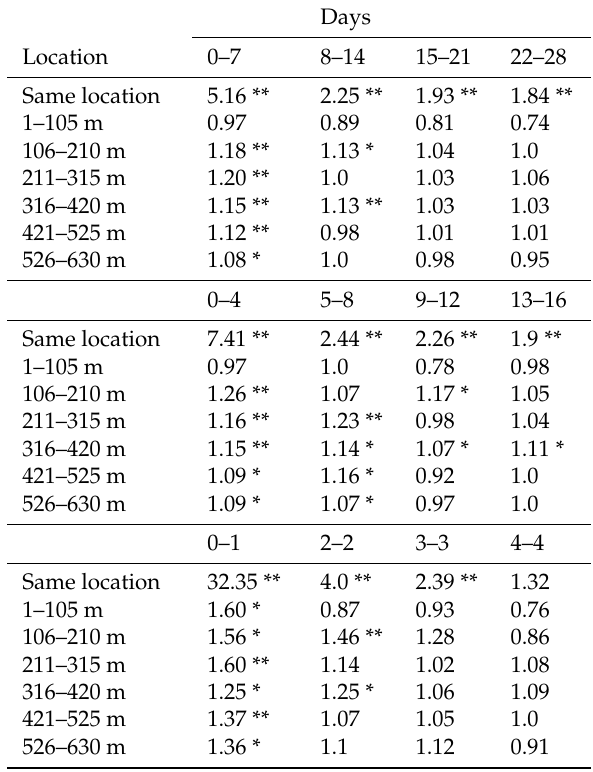
Table 1. Observed-to-expected mean frequencies for street robberies in Malmö in 2006–15 with temporal bandwidths of 1, 4, and 7